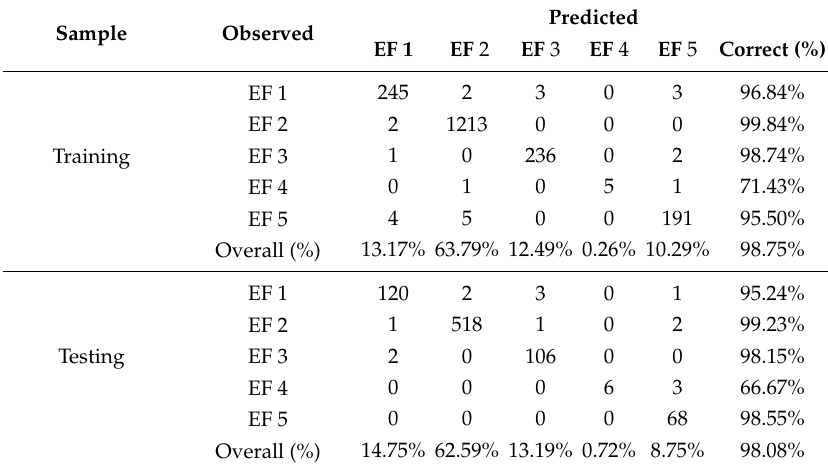
Table 4. Confusion matrices for training and testing